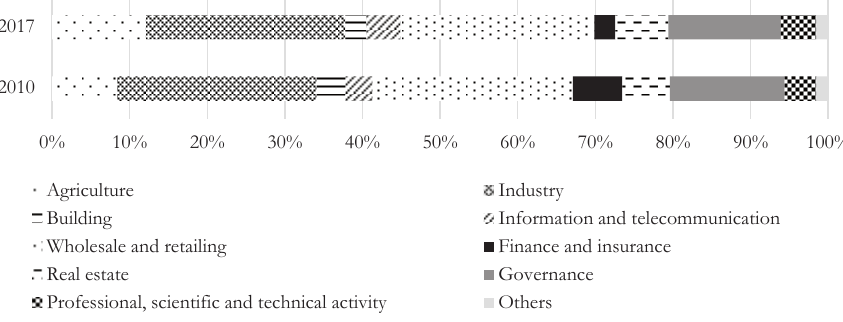
Fig. 7 – The share of expenditures for implementation of scientific researches and developments in Ukraine. Source: State Statistic Service of Ukraine (2018)